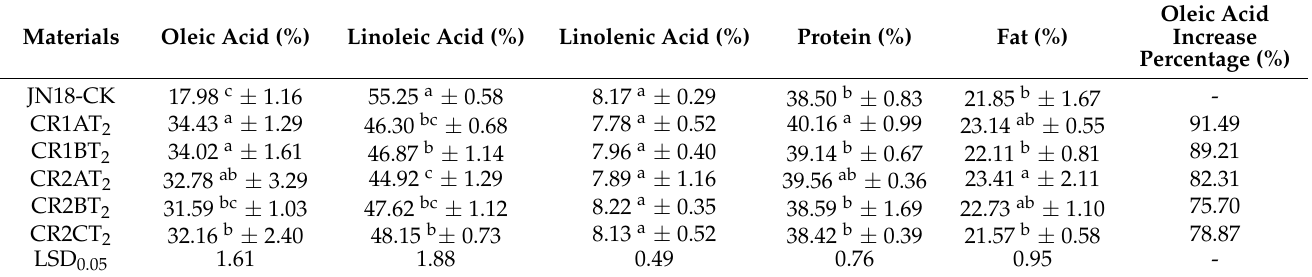
Figure 11. Comparison of quality traits of different mutation types. Significant differences according to Student’s t-test are indicated. **, and *** indicated significant differences at p < 0.01, and p < 0.001 levels, respectively. Table 2. Determination of fatty acid content of different editing vectors in T 2 plants.